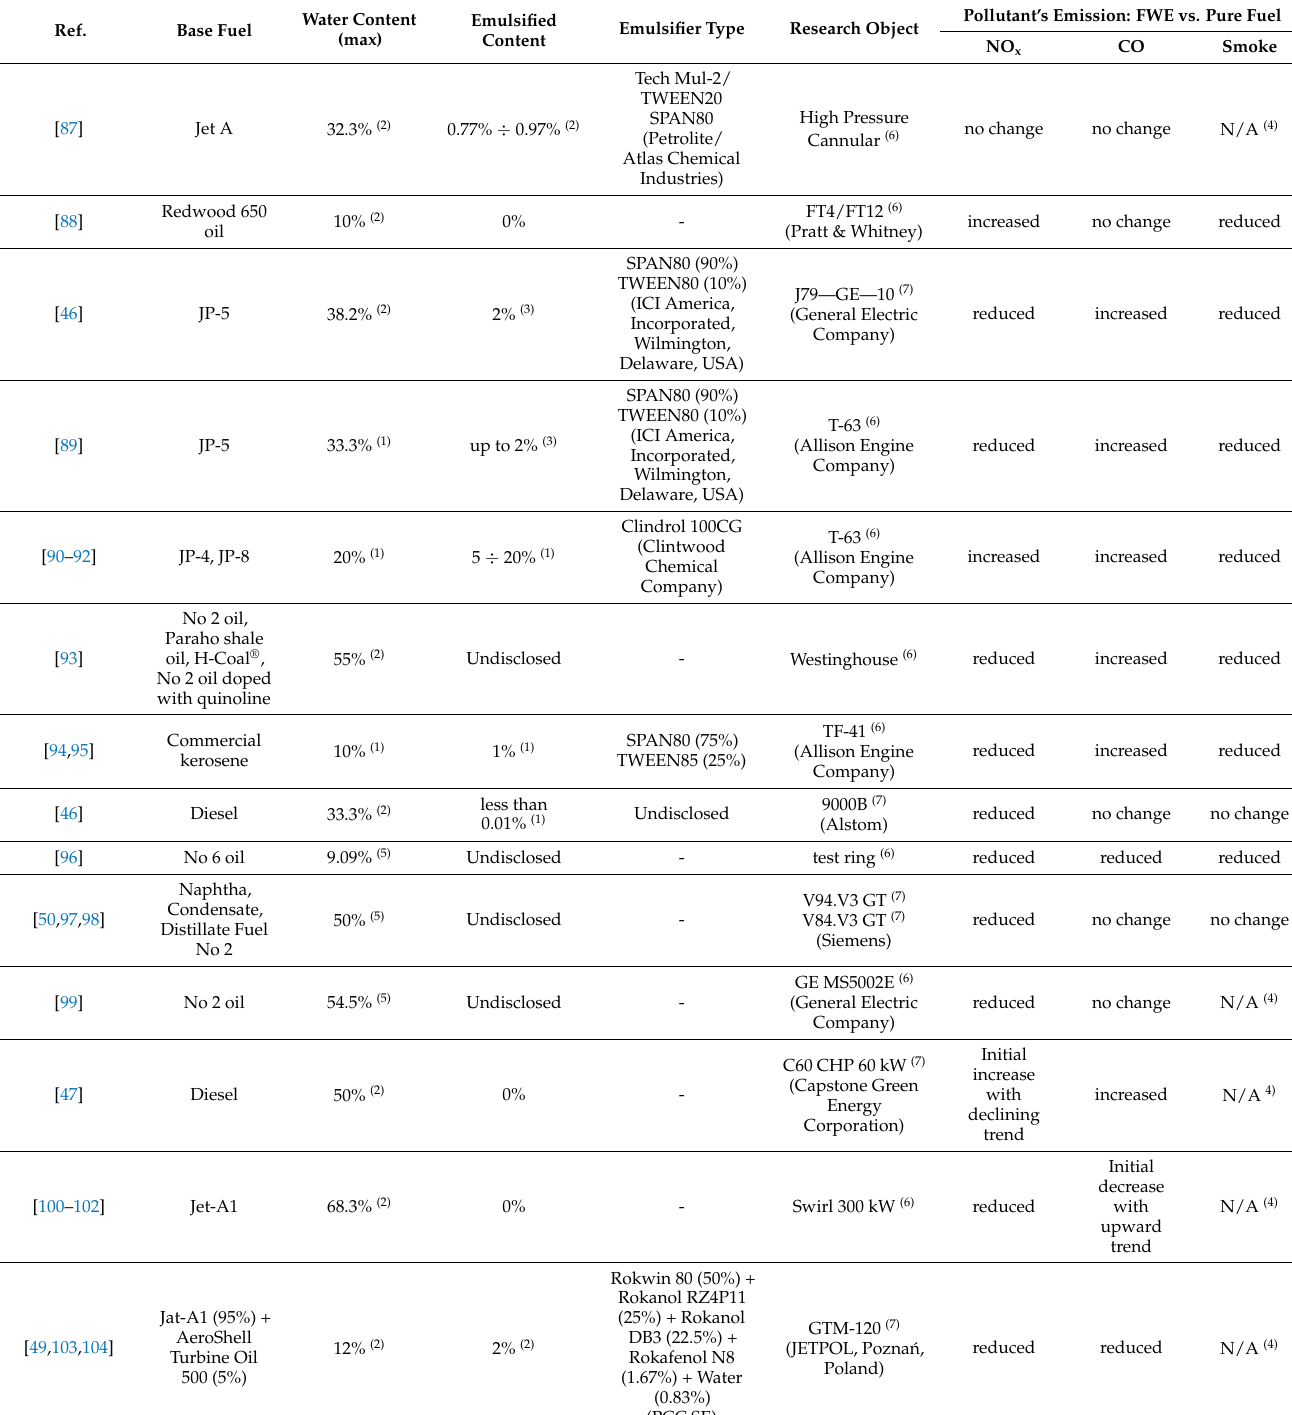
Table 1. Summary of the literature